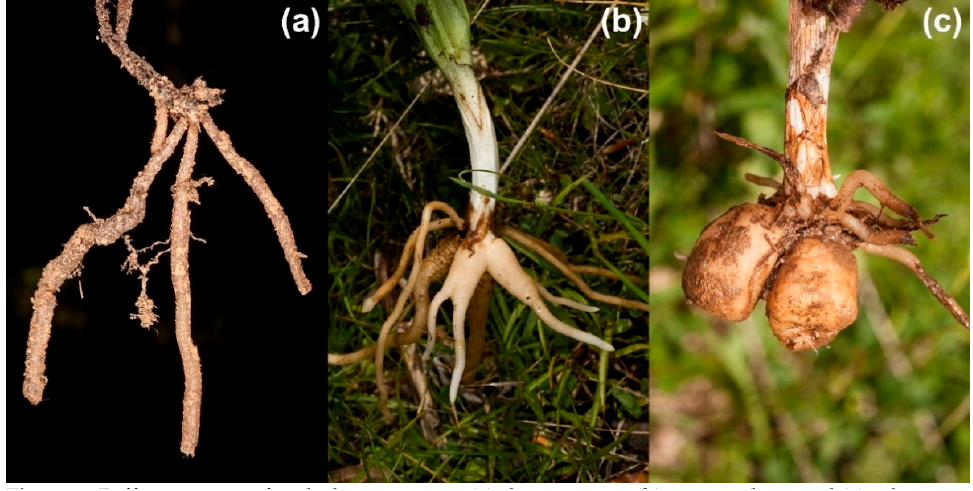
Figure 1. Different types of orchid root system: ( a ) rhizomatous, ( b ) intermediate and ( c ) tuberous. Tsiftsis et al. [8] report that species richness of orchids with these three rooting systems is significantly associated with altitude, whereas the degree to which an orchid species is specialized to specific environmental conditions (e.g., their mean species specialization index that will be described later here) are largely associated with their evolutionary history, represented by their rooting system.